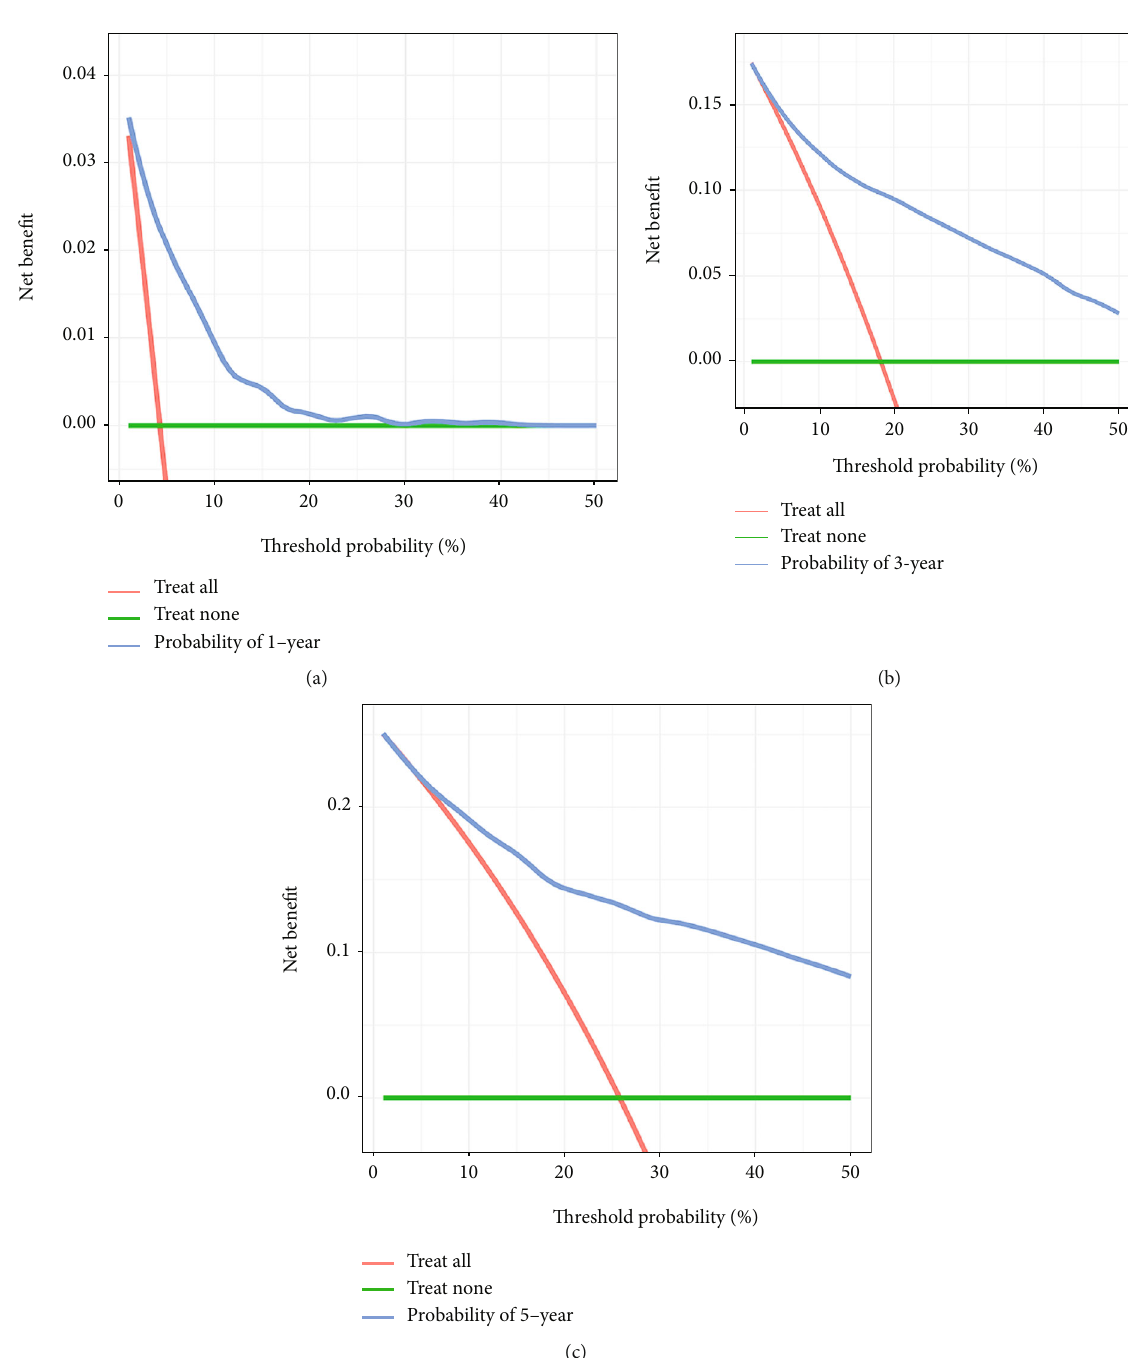
Figure 7: The decision curves in the validation dataset (from left to right are the decision curves for the prediction of survival in year 1, year 3, and year 5,